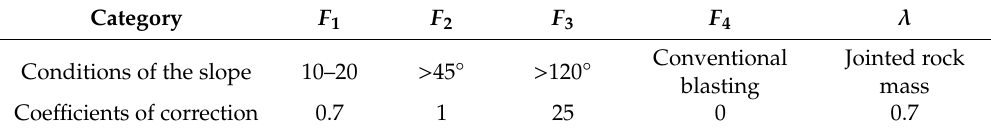
Table 5. Coe ffi cients of correction in the CSMR (classification of slope mass rating)